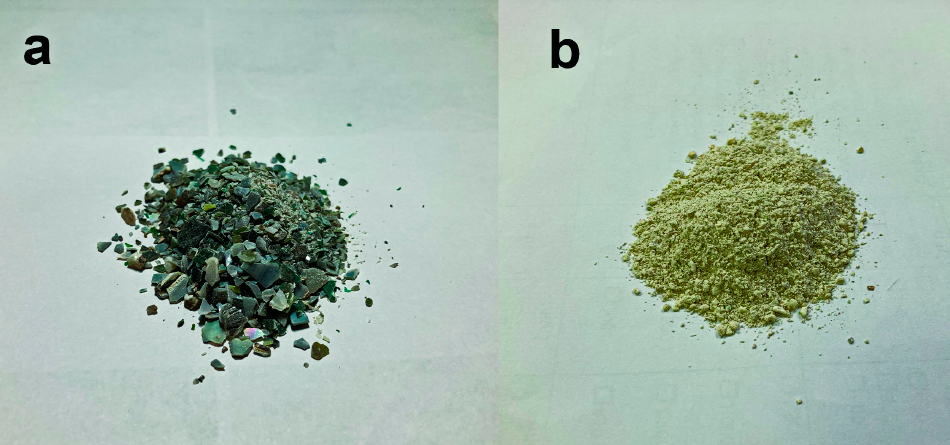
Figure 1. Prepared mussel shell waste. ( a ) Crushed green mussel shells and ( b ) mixed shell powder from the local market.